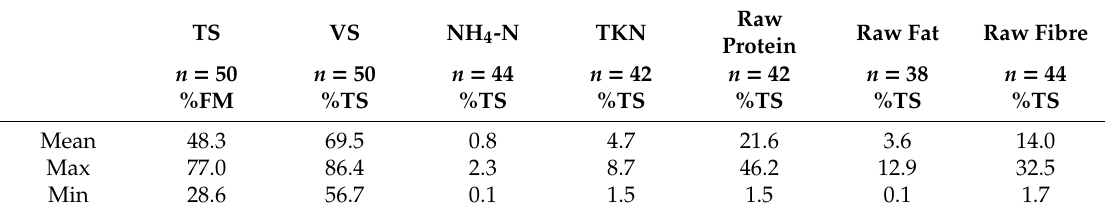
Table 2. Material characteristics of chicken